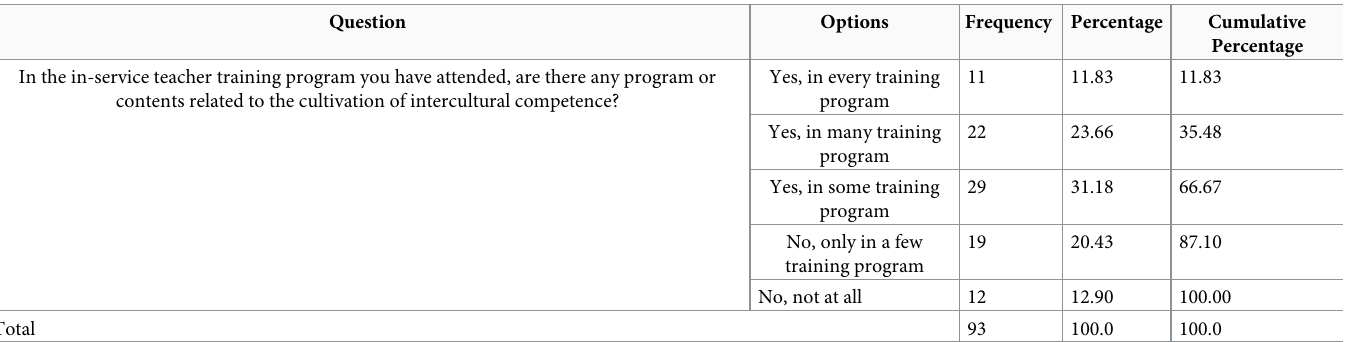
Table 9. Teacher training programs related to intercultural